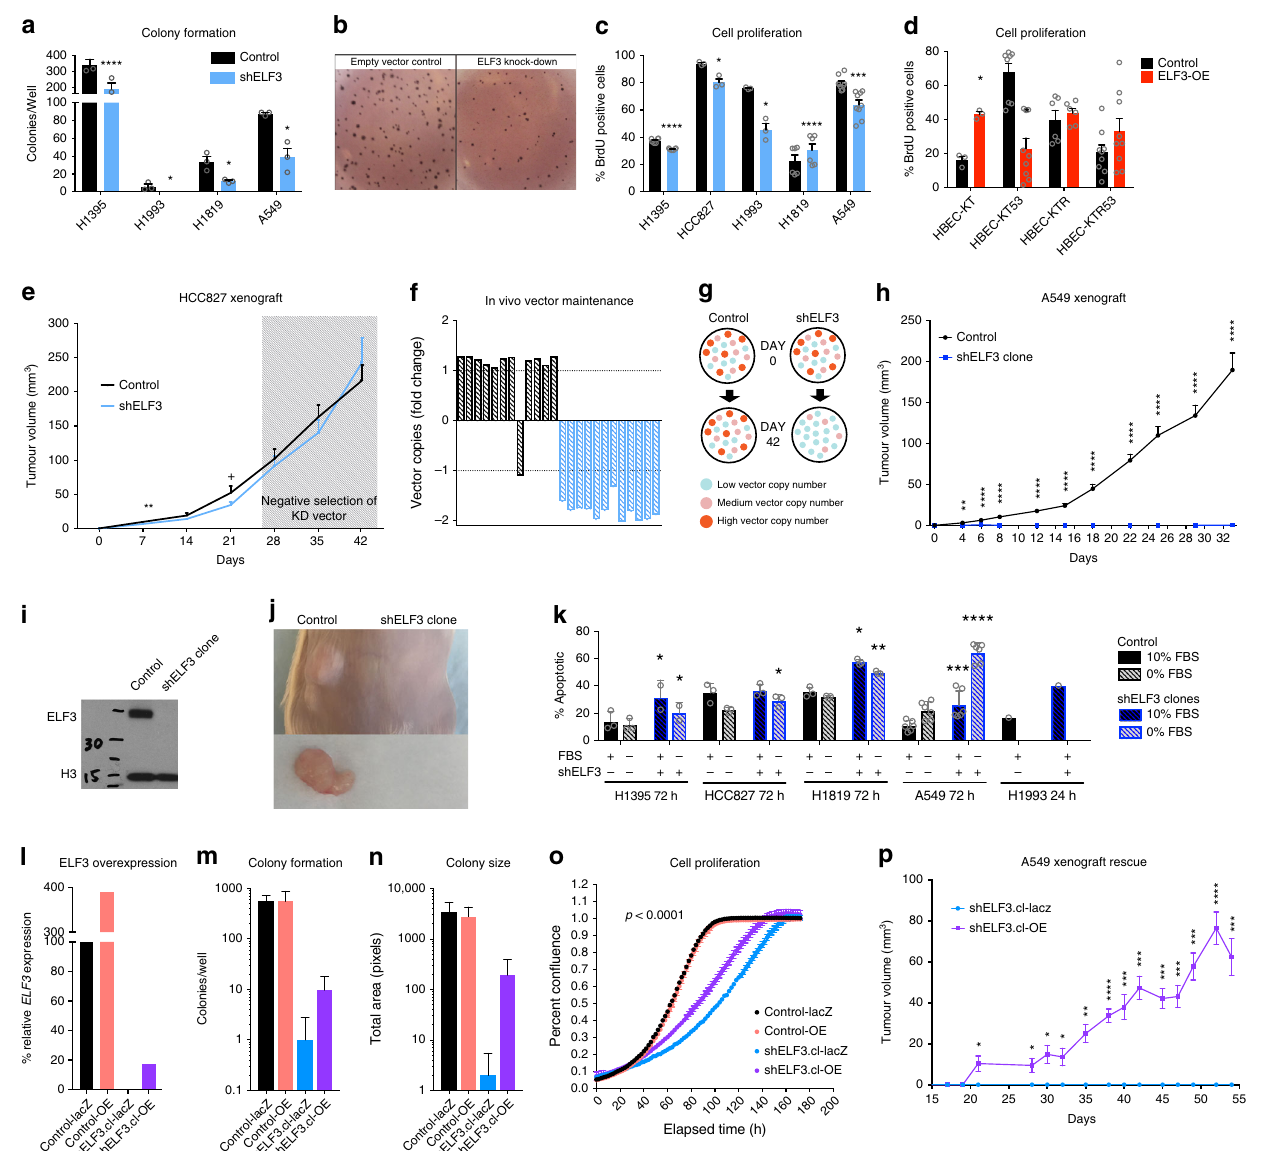
Fig. 4 Manipulation of ELF3 expression regulates oncogenic phenotypes. Histogram summarizing the effect of shRNA-mediated ELF3 inhibition on a , b soft agar colony formation and c cell proliferation in lung adenocarcinoma cell lines, and d the effect of forced ELF3 overexpression (OE) on cell proliferation in HBEC-KT cell lines with and without p53 knockdown (HBEC-KT53) and/or induction of KRAS (HBEC-KTR, HBEC-KTR53). e Tumor growth of isogenic HCC827 shELF3 and control cells in NOD-SCID mice ( n = 12). f Quanti fi cation of shELF3 and control vector DNA copy number in endpoint tumors compared with input material. g Putative model of clonal drift throughout xenograft tumor growth. At Day 0 we assume a mixed population of cells with low (blue), medium (pink), and high (orange) vector copy numbers (CN) for both populations. Over time, the relative proportion of low shELF3 vector CN clones dominates owing to the growth advantage provided by ELF3 expression. h Tumor growth curve of clonal populations of isogenic A549 shELF3 and control cells in NOD-SCID mice ( n = 24). i ELF3 expression of input clones as measured by immunoblot. j Control and absent shELF3 tumors at endpoint. k Cell viability as measured by annexin/PI staining of control (black bar) and clonal shELF3 (blue bar) LUAD cell lines cultured in complete (10% FBS, solid fi ll) or serum starved (0% FBS, hatched fi ll) media (H1993 n = 1 replicates owing to viability issues). l qPCR of ELF3 mRNA expression in control and shELF3 clonal cell lines with forced ELF3-OE or empty vector control (lacZ). Histograms summarizing the effect of ELF3 overexpression on colony formation, in terms of number m and size n of colonies formed (paired two-tailed Student ’ s t test). o Cell proliferation shows rescued growth rate with ELF3-OE in A549 cells (Wilcoxon test). p Tumor growth of shELF3.cl-lacZ and shELF3.cl-OE A549 cells in NRG mice ( n = 8). In all box and whisker plots, center line represents the median, box bounds indicate the 25th and 75th percentiles, and whiskers extend from minimum to maximum, all histograms display the mean + SEM ( n = 3 biological replicates unless otherwise stated). CN = copy number, + p < 0.10, * p < 0.05, ** p < 0.01, *** p < 0.001, **** p < 0.0001, paired two-tailed Student ’ s t